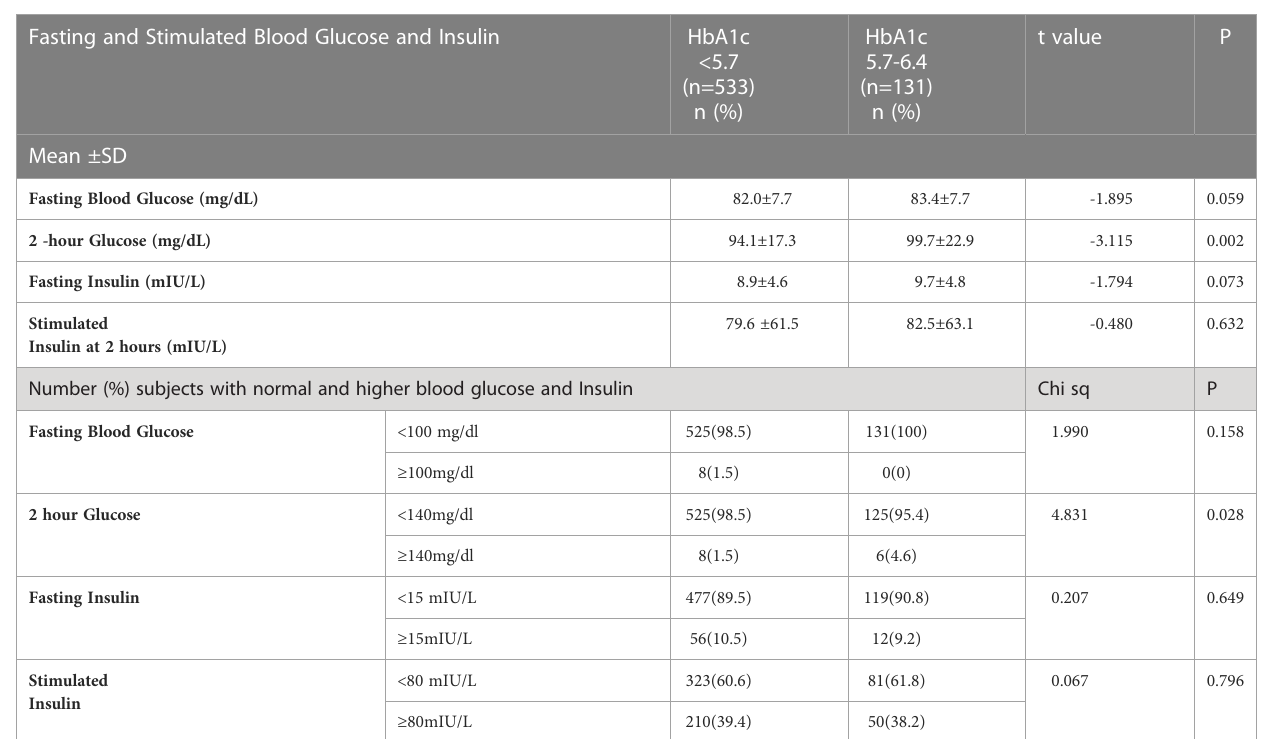
Stimulated Insulin at 2 hours (mIU/L) Number (%) subjects with normal and higher blood glucose and Insulin Fasting Blood